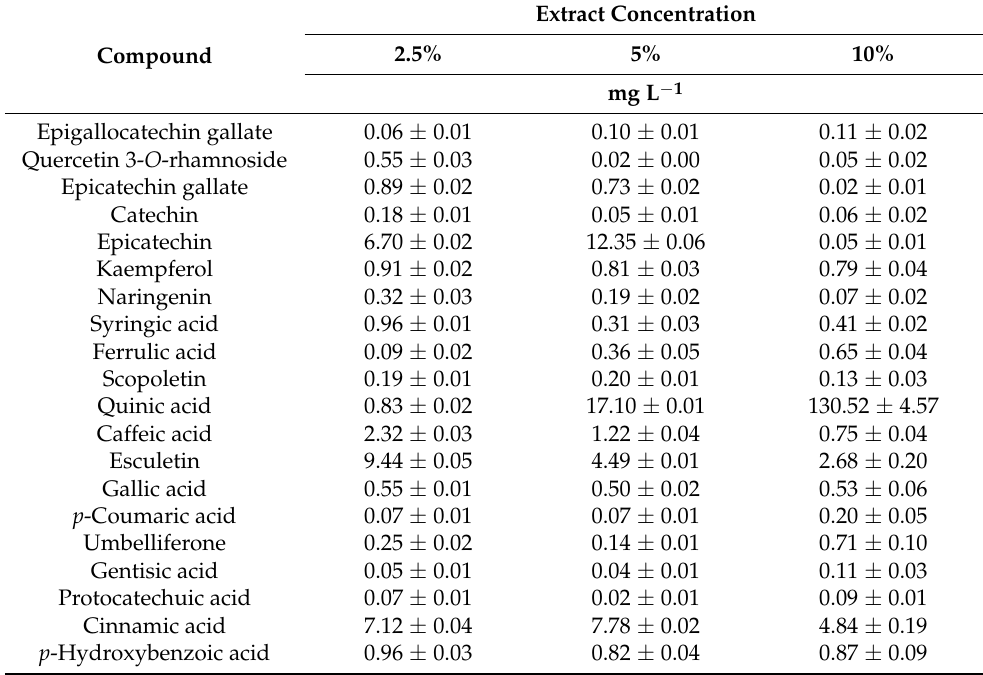
Table 1. Phytochemical composition of chia ( S. hispanica L.) aqueous extracts of different